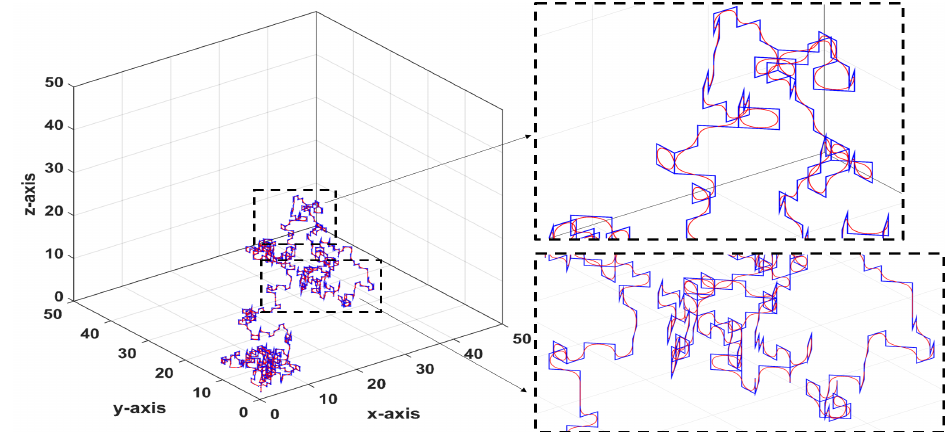
Figure 17. Simulation of motion for 500 iterations of the algorithm and B-Spline curve